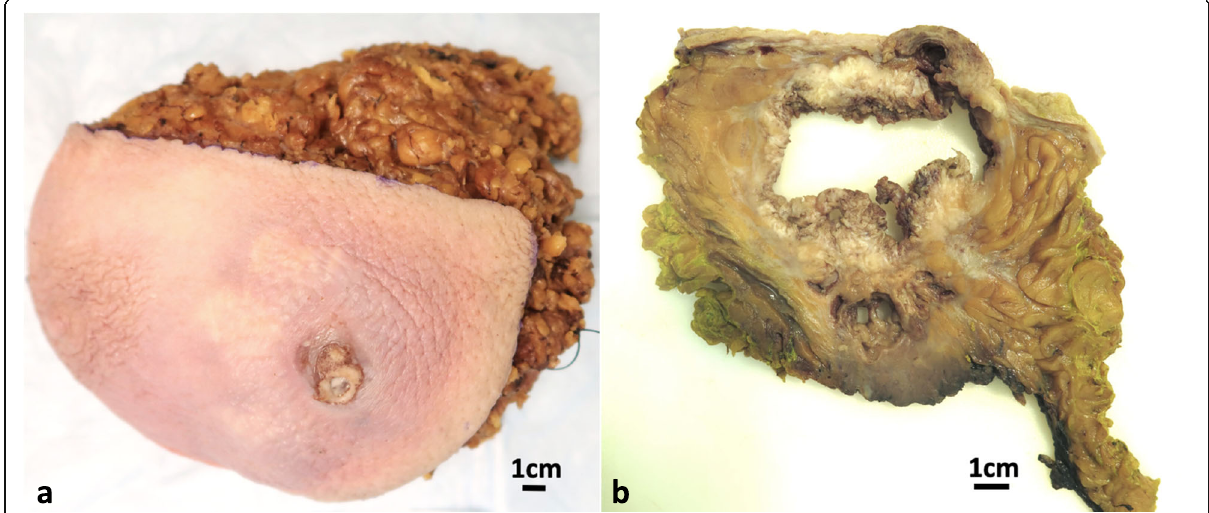
Fig. 3 Gross examinations for left breast lesion. a Gross image for the left breast. An area of skin disruption was present in a background of erythematous skin change. b Cut surface of the left breast lesion showing an irregular tan-white lesion with central cystic change. The lesion was not grossly connected with the overlying